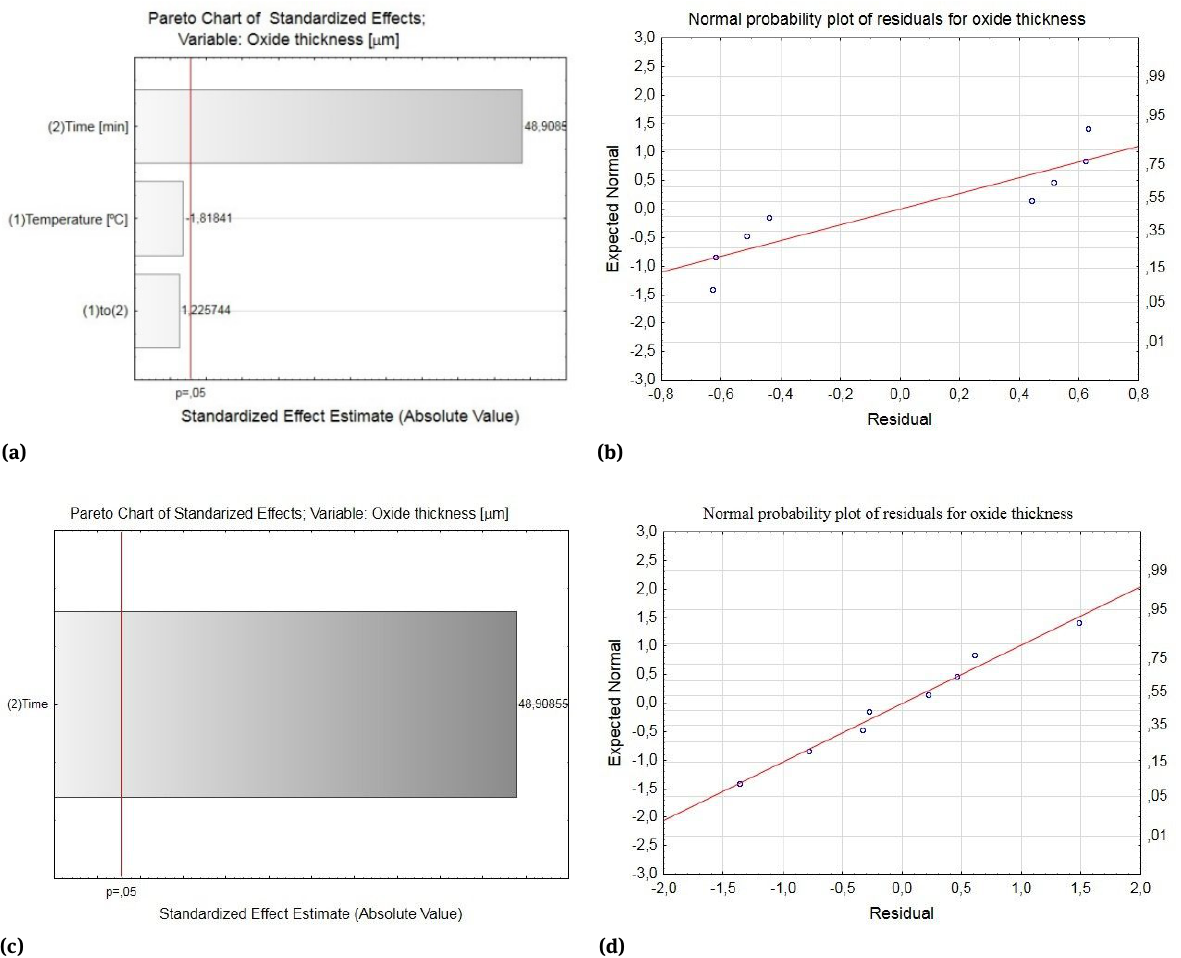
Figure 3: Two-factor model with interaction (a) The Pareto chart of standardized effects for oxide thickness, (b) the normal probability plot of residual for oxide thickness variable; Linear univariate model (c) The Pareto chart of standardized effects for oxide thickness, (d) the normal probability plot of residual for oxide thickness